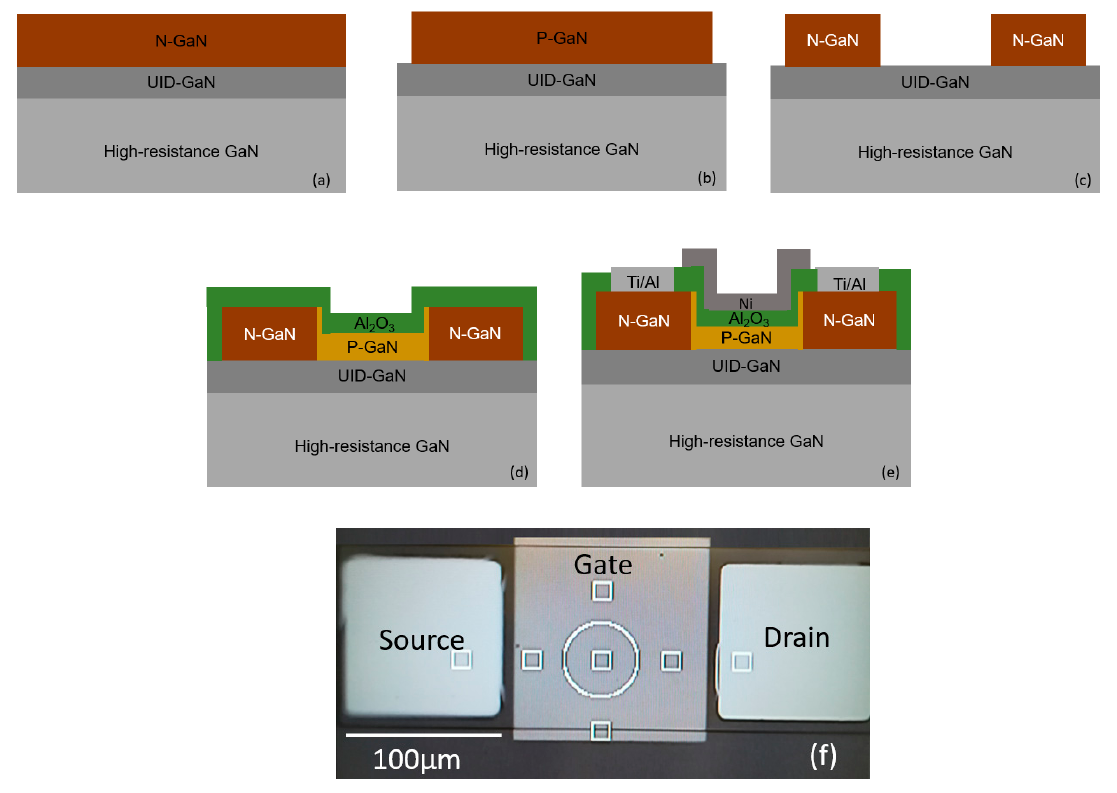
Figure 2. Fabrication process of the gallium nitride-metal-oxide field-effect transistors (GaN-MOSFETs) fabricated using the regrowth method. ( a ) n-GaN grown on a free standing GaN substrate, ( b ) mesa structure, ( c ) etching n-GaN layer on the gate-body region, ( d ) regrowth of p-GaN and Al 2 O 3 deposition, ( e ) contact deposition and annealing, ( f ) the top view of the fabricated MOSFETs.